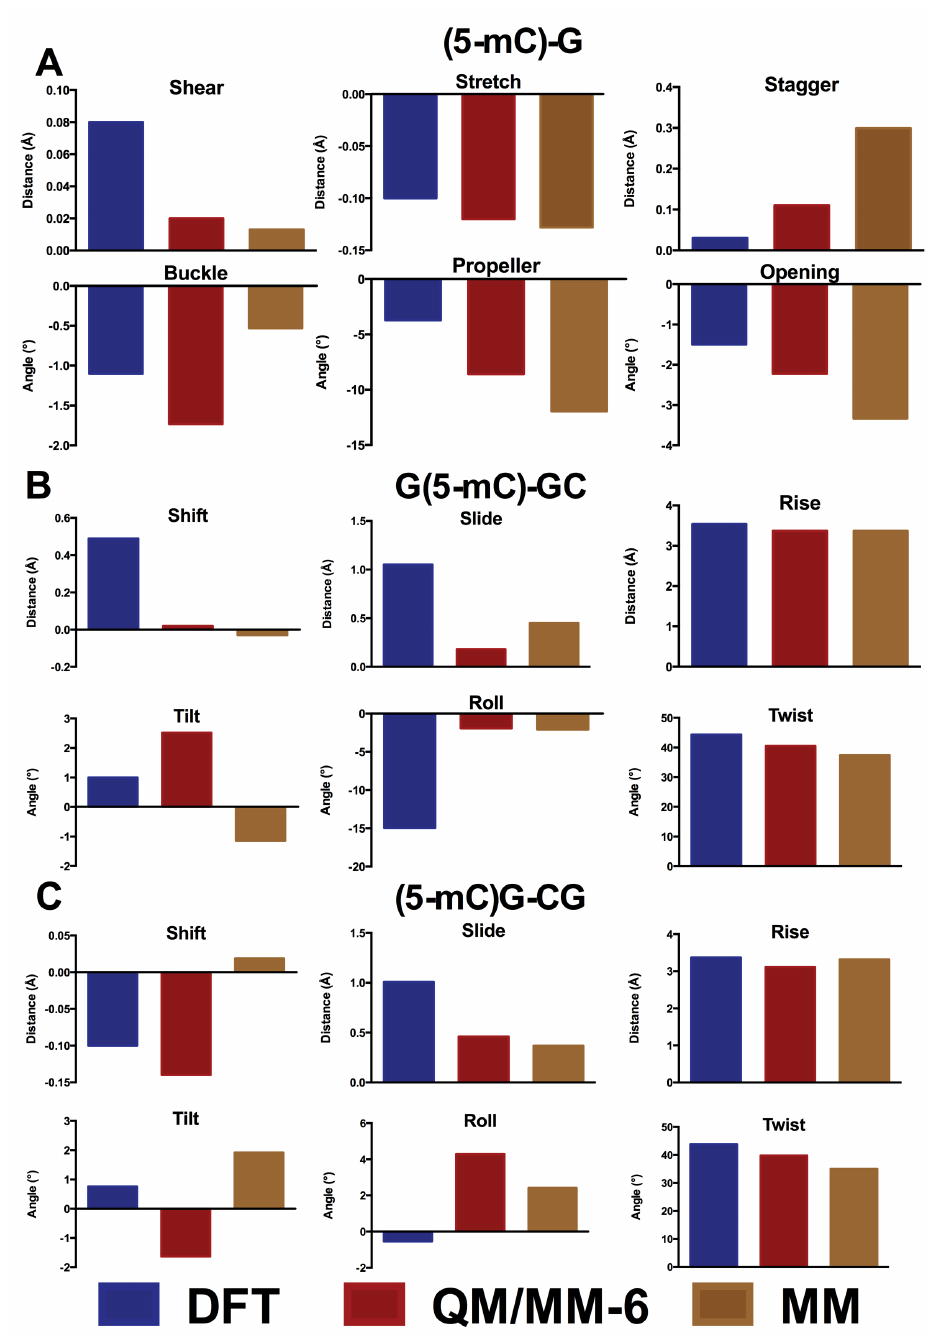
Figure 5. Comparison of DFT, QM/MM and molecular mechanics energy minimised (EM) geometries of d(GC´G) (Å and °). The corresponding values are shown in Data file 3–Data file